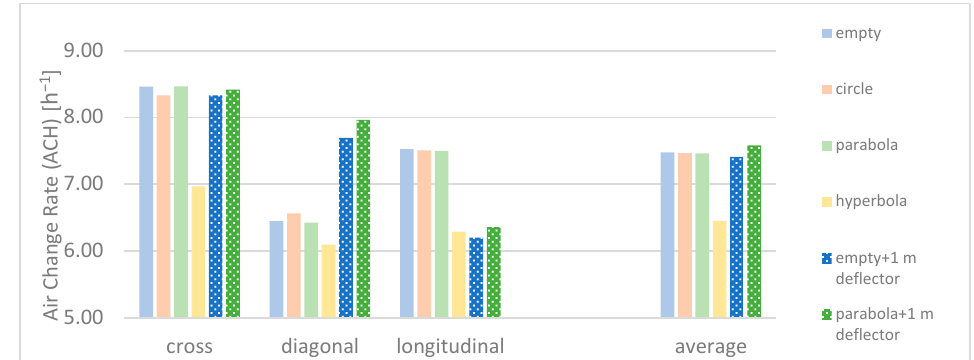
Figure 13. Comparison of geometry variations’ performance in ACH [h − 1 ] with added deflectors to ‘empty’ and ‘parabola’ versions.